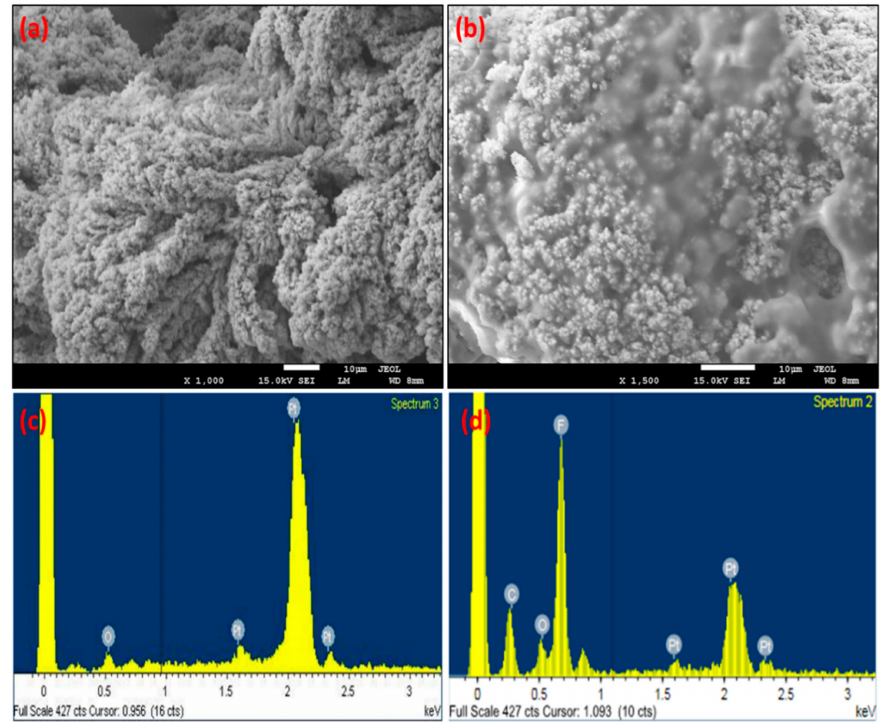
Figure 2. SEM images EDX spectra of Au/Pt-black MNEA ( a ) and Au/Pt-black/Nf MNEA ( b ) showing a drift change in the surface morphology after packaging the Au/Pt-black electrode with Nf ionomer. EDX spectra of Au/Pt-black MNEA ( c ) and Au/Pt-black/Nf MNEA ( d ) showing the presence of elements Pt and Pt, C, O, F for Au/Pt-black and Au/Pt-black/Nf MNEAs